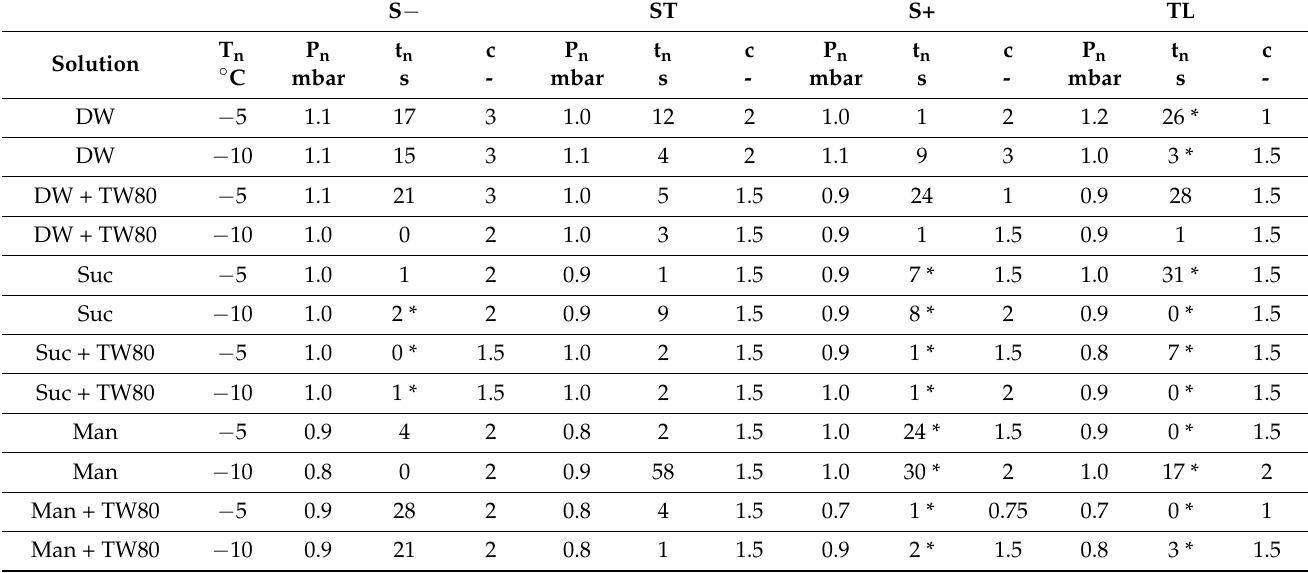
Table 4. Nucleation pressure P n , nucleation time t n , and c factor (see Equation (1)) for the different solutions and vial types considered in the present work. If a * is present in the t n column, blow up was observed. S − : untreated, ST: sulfate treated, S+: siliconized, TL: TopLyo. S − ST S+ TL